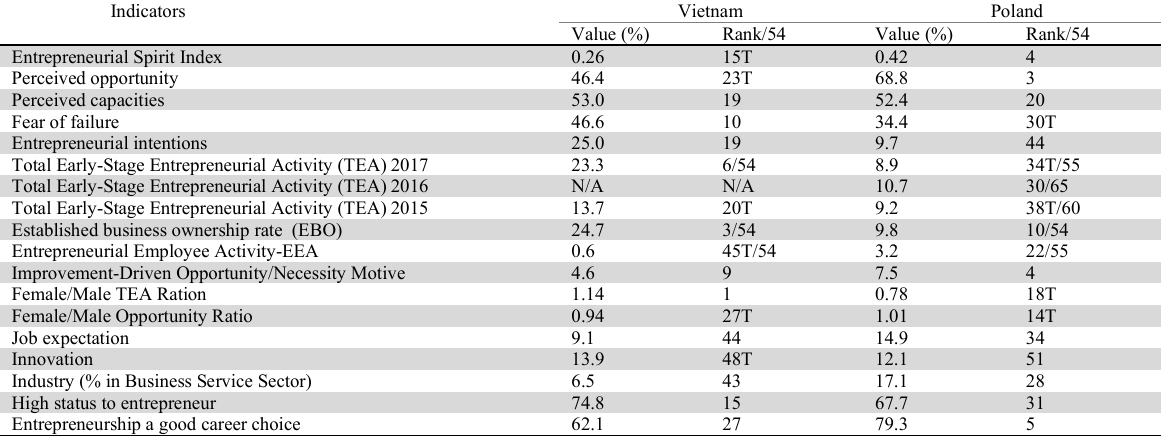
Key entrepreneurial indicators for Vietnam and Poland